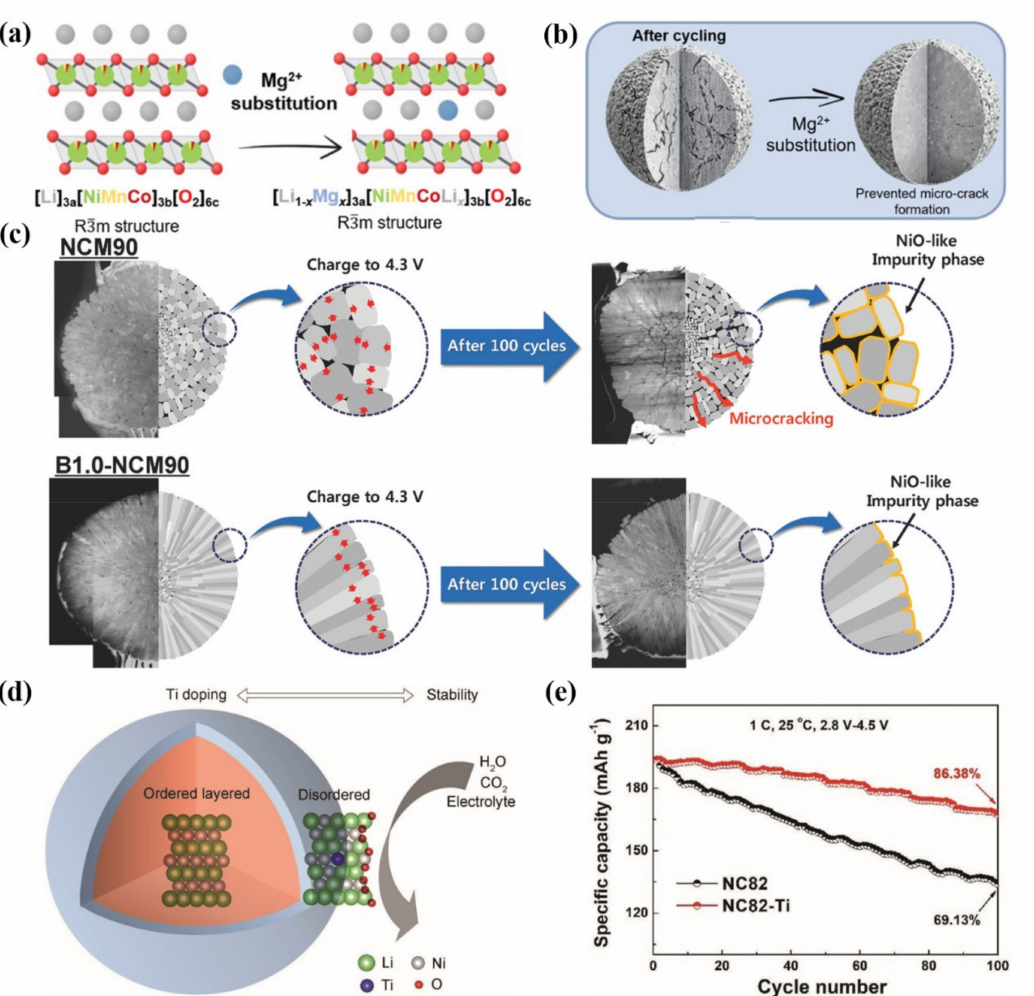
Figure 6. ( a ) The layered crystal structure of a Mg-substituted [Li 1 − x Mg x ] 3a [NiMnCoLi x ] 3b [O 2 ] 6c structure with R3m space group symmetry. ( b ) Schematic diagram of Ni-rich NCM without doping and Mg-substituted Ni-rich NCM after cycling. Reproduced with permission from ref. [69]. Copyright 2022 John Wiley and Sons. ( c ) Schematic diagram for the effect of boron-doping on the NCM90 cathode’s mechanical stability during charge and discharge cycling. Reproduced with permission from ref. [60]. Copyright 2018 John Wiley and Sons. ( d ) Schematic diagram for the mechanistic understanding of Ti doping. ( e ) The cycling performance for NC82 and NC82–Ti at 1 C in 2.8–4.5 V. Reproduced with permission from ref. [70]. Copyright 2019 John Wiley and